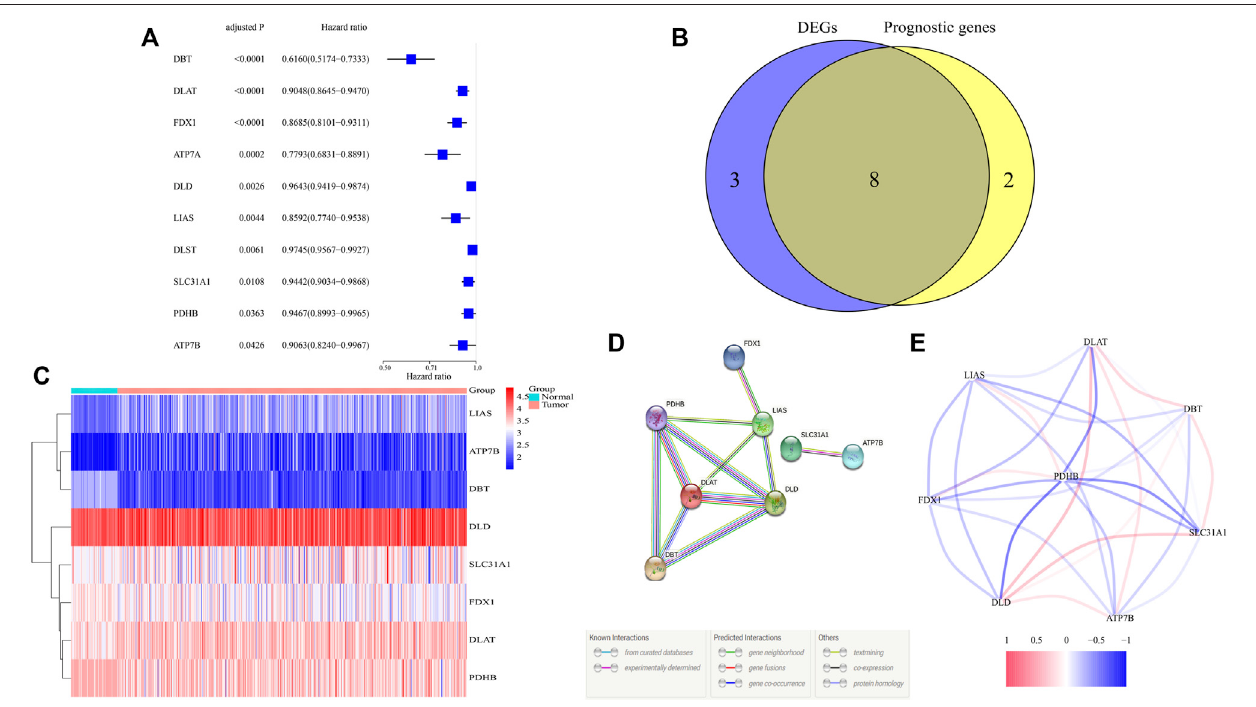
FIGURE1 | Identi fi cation of candidate cuproptosis-related genesin TCGA. (A) Univariate Cox regressionanalysisof 10cuproptosis-related genes with p < 0.05 in patients with ccRCC. (B) Venn diagram identifying differentially expressed genes correlated with OS. (C) Heatmap of the expressions of eight overlapping genes. (D,E) PPI (interaction score = 0.4) and correlation network of cuproptosis-related genes.